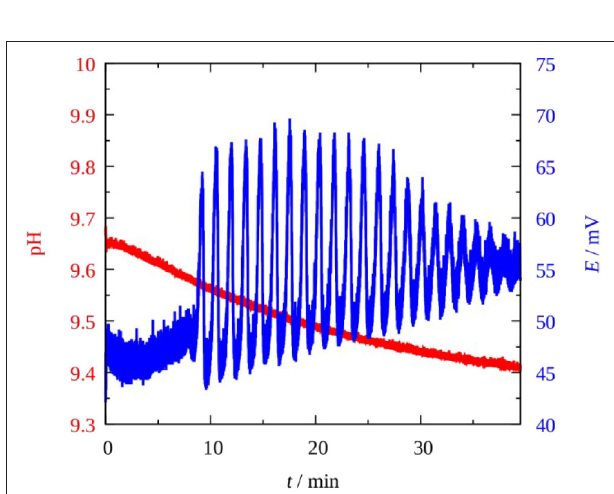
FIGURE 2 | Potential oscillations in the Pt vs. SCE electrode pair (blue) and the change in the pH (red) in the Cu 2 + -catalyzed sodium perborate–potassium thiocyanate batch system. [NaBO 3 ] = 0.030M; [HCl] = 1.5 × 10 − 3 M; [KSCN] = 0.025M; [Cu 2 + ] = 10 − 4 M; T = 25 ◦ C.